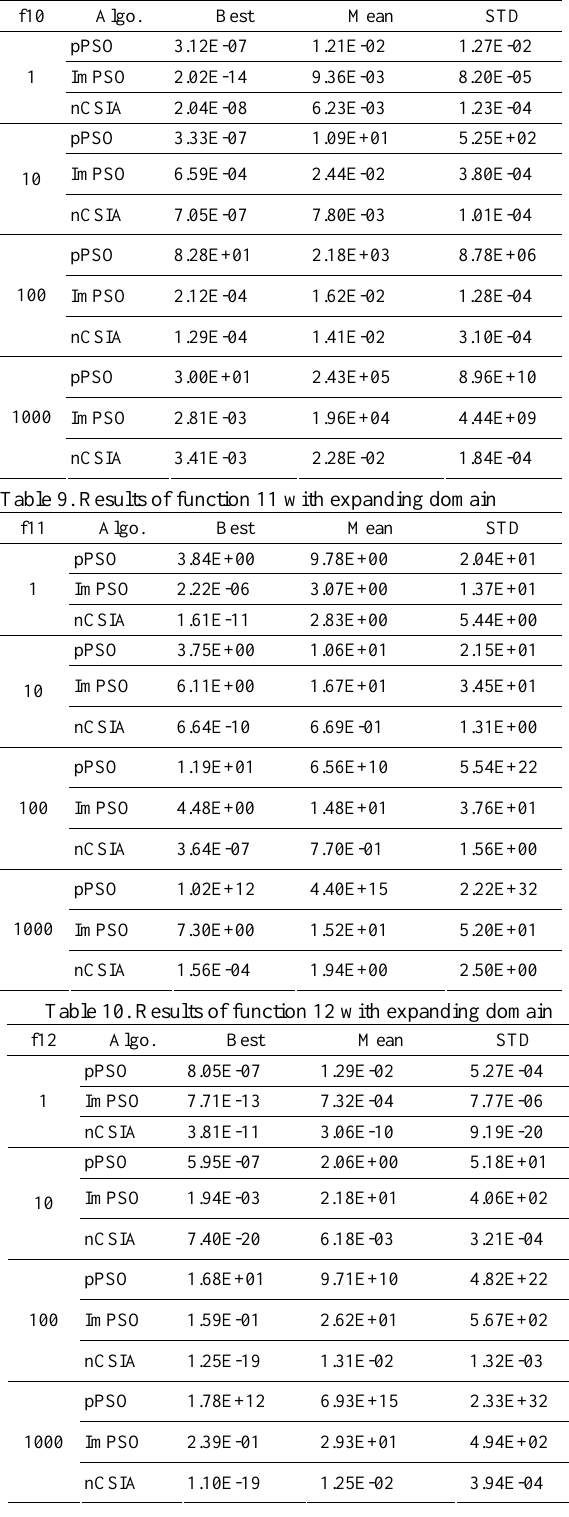
Table 11. Results of function 1 with increasing dimension